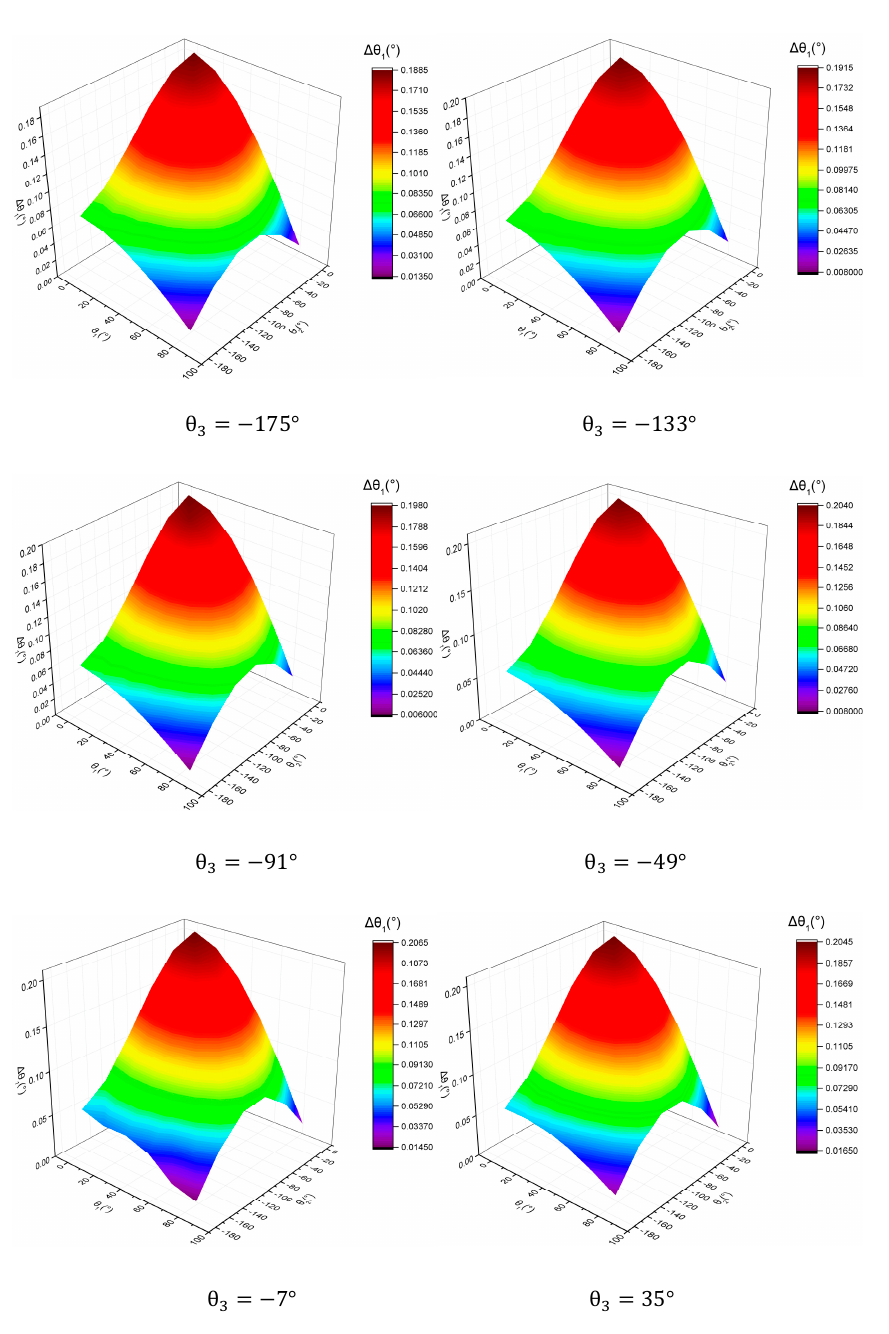
Figure 7. Relationship of compensation angle of the 1st joint angle and each joint angle.